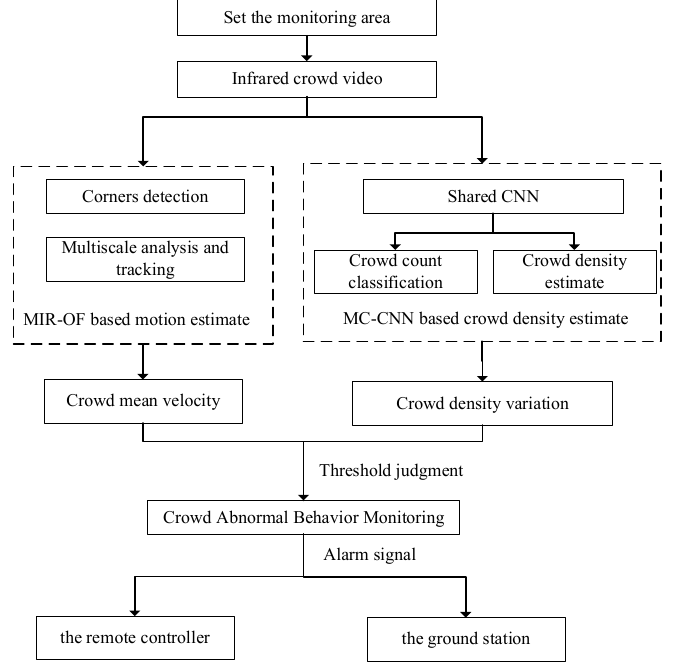
Figure 2. Framework of the proposed UAV system.